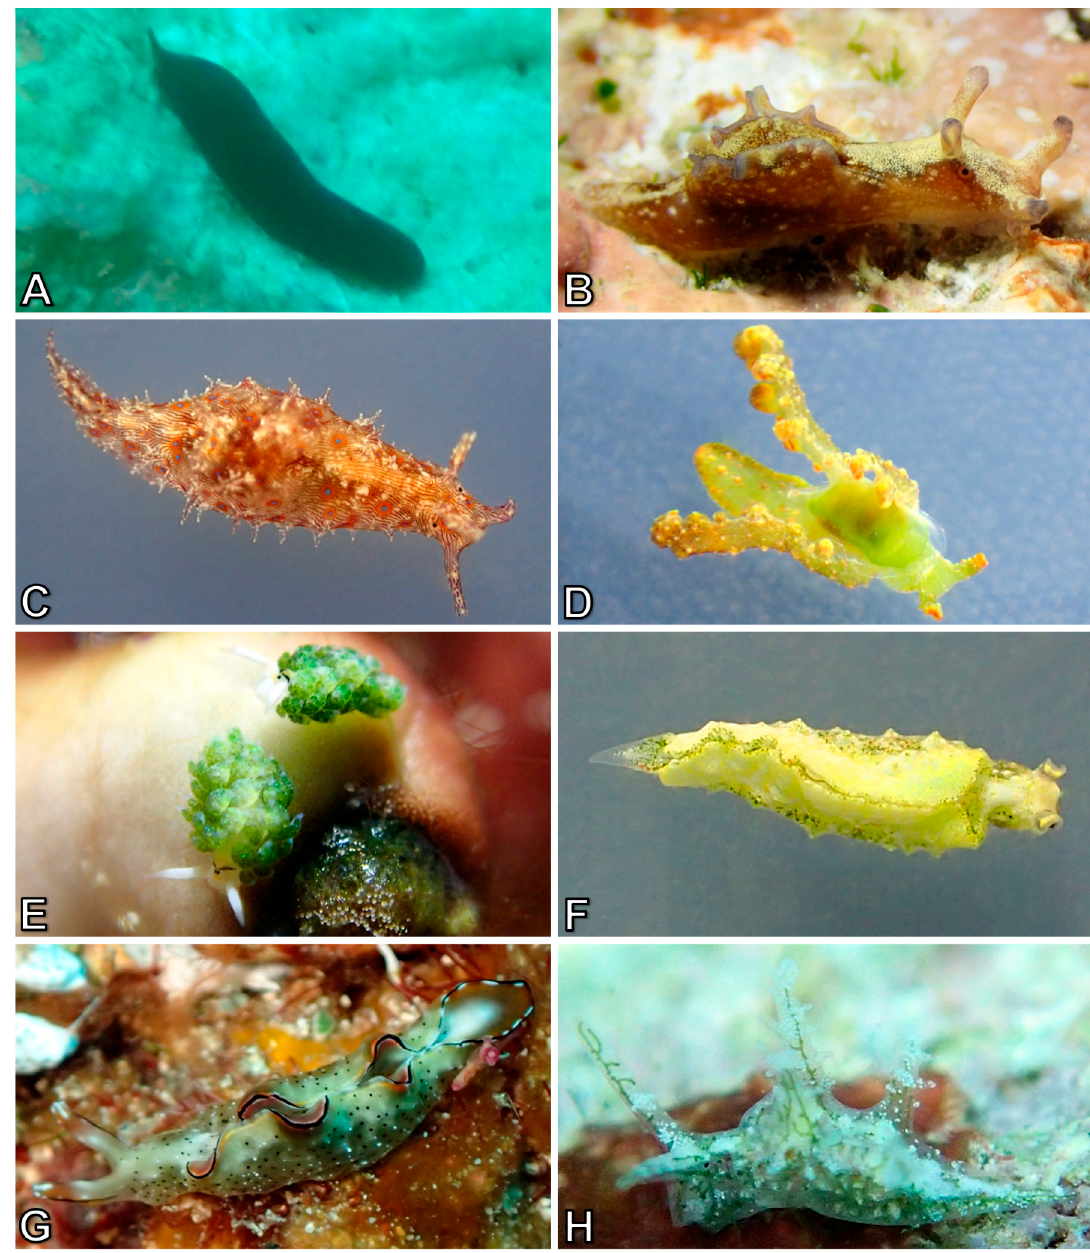
Figure 4. Runcinacea, Anaspidea and Sacoglossa: ( A ) Runcina spec., Rusp2_16Bu-1; ( B ) Aplysia parvula ; ( C ) Stylocheilus striatus ; ( D ) Lobiger spec. ( Lobiger sp. 1 in Gosliner et al. [11]: 70), Losp1_16Bu-1; ( E ) Costasiella spec., Cosp3_16Bu-1; ( F ) Elysia asbecki ; ( G ) Elysia marginata ; ( H ) Elysia mercieri . 3.1.2. Anaspidea (two species in two genera belonging to one family, Figure 4B,C) Aplysia parvula is a circumtropical species which might represent a species complex [11,23]. Our specimens (Figure 4B) showed the typical pinkish color with cream-colored dots, and darker parapodial and rhinophoral rims of the form associated with algae on coral reef flats and the intertidal [24]. They were collected in coral rubble in less than 7 m depth.